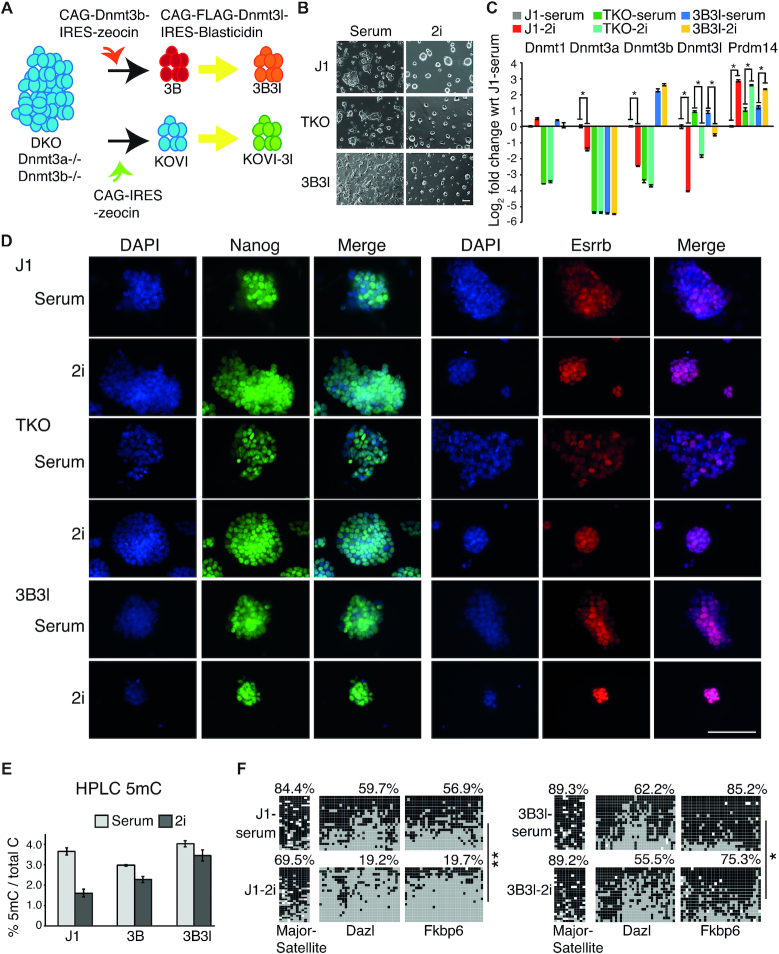
J1, TKO and 3B3l mESCs achieve ground state in 2i. (A) Schematic showing cell line derivation. An expression construct for the co-factor Dnmt3l was added to Dnmt3a/3b knockout mESCs rescued by exogenous constitutive expression of Dnmt3b (3B) to create a Dnmt3a/3b knockout expressing both Dnmt3l and Dnmt3b (3B3l). Dnmt3l was also added to a to Dnmt3a/3b knockout mESCs (KOVI) to create KOVI-3l. (B) Morphology images of mESCs in indicated culture conditions. Scale bar 100 μm. (C) Expression levels of indicated Dnmt's and Prdm14. For each gene, fold change with respect to (wrt) average J1-serum probe value is represented (as log2) with SEMs. * indicates P < 0.05 (unpaired t-test). (D) Immunocytochemistry images of indicated conditions showing Nanog (green) and Esrrb (red) with DNA counterstaining (DAPI, blue) and merge. Scale bar 100 μm. (E) HPLC quantification of 5mC levels of indicated mESCs, bars represent mean ± SD of 2–3 biological replicates. (F) Bisulfite sequencing data for indicated gene promoters and cell lines, black: methylated CpG, grey: un-methylated CpG, white: missing data. Numbers represent percentage of methylated CpGs. * (black: methylated CpG, grey: un-methylated CpG, white: missing data). *P < 0.05, ** P = 0.00578, two2-tailed Mann–Whitney U-test.